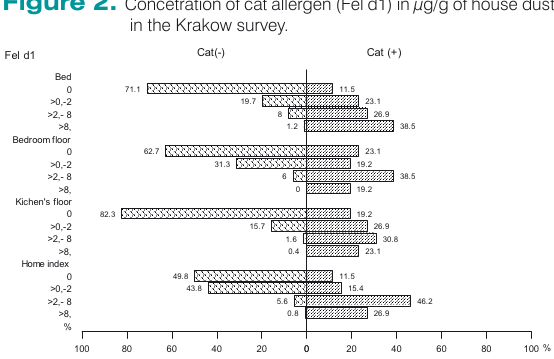
Figure 2. Concetration of cat allergen (Fel d1) in µg/g of house dust in the Krakow